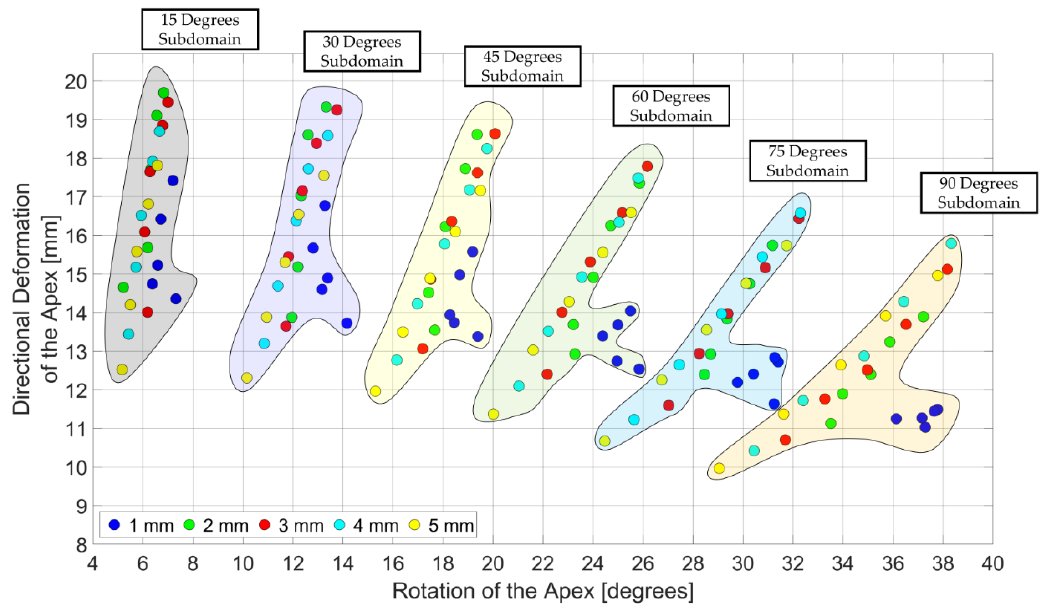
Figure 9. Design domain of the LV simulator. Subdomains were identified with respect to the orientation angle and legend represents the wall thickness of the LV simulator.